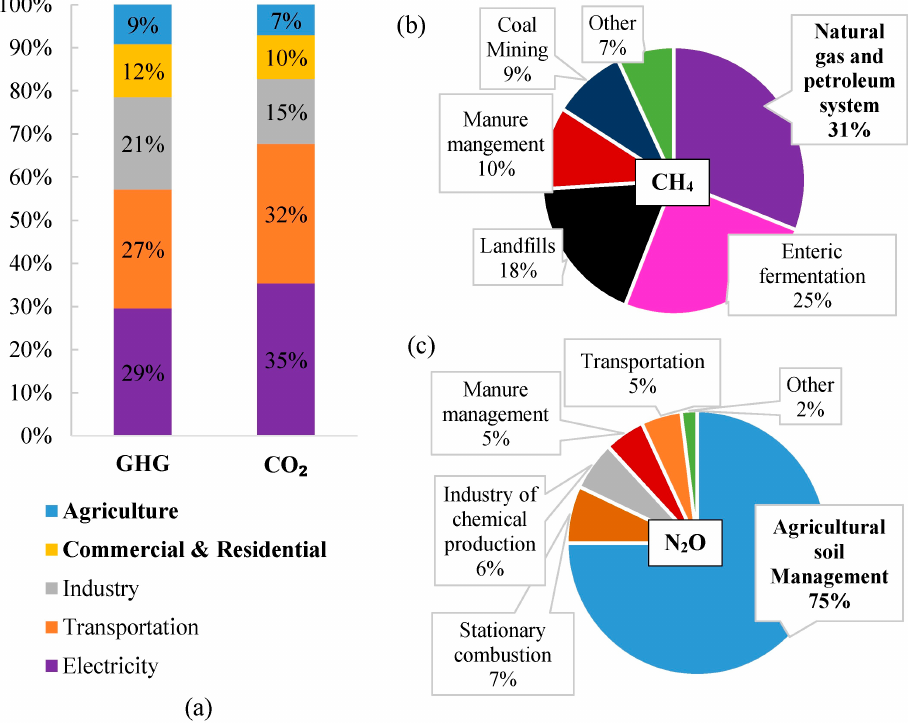
Figure 1. Percentage of pollutant emissions by industry [2]. ( a ) Total emission percentage, ( b ) CH 4 emission percentage; ( c ) N 2 O emission percentage.